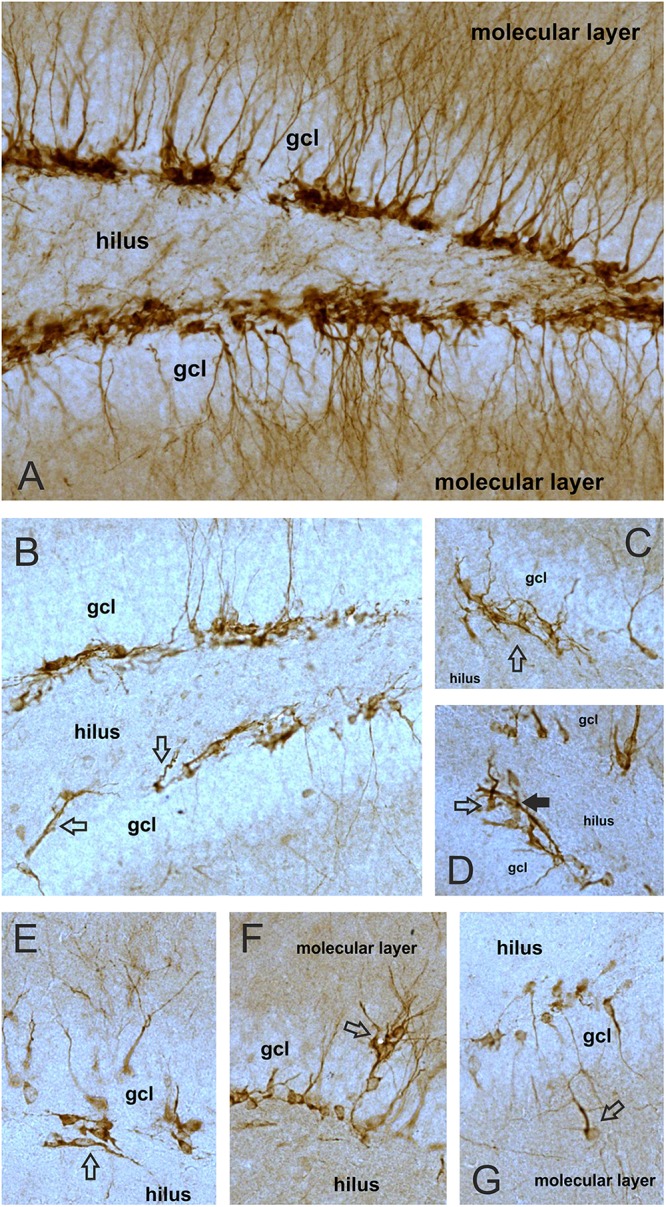
Long-term cannabis exposure alters the morphology of DCX-positive neurons. Representative images demonstrating DCX+ immature neurons with normal appearance in a control animal (A) and cells with abnormal morphology in cannabis treated mice (B–G). (A) In control mice almost all the DCX+ neurons were located in the subgranular zone, i.e., in a cell layer between the hilus and granule cell layer (gcl). Normal DCX+ cells had DCX-expressing dendrites projecting through the gcl and arborized in the molecular layer. The principal dendrites were typically running parallel to each other in the gcl giving an orderly, well-aligned appearance to the neurons. (B) DCX+ neurons in the cannabis treated animals often lost their dendritic DCX-expression. Arrows point to neurons with abnormal dendritic projections into the hilus. (C) DCX+ neurons with dendrites projecting into all directions, giving a disorganized, chaotic appearance to the neurons. (D) Open arrow points to a neuron with basal dendrites, i.e., with dendritic projections into the hilus. Black arrow points to a cell with bipolar appearance. (E) A bipolar DCX+ neuron in the hilus with dendritic projections running parallel to the gcl. (F) Neurons migrating out of the gcl into the molecular layer. (G) An ectopic DCX+ neuron with basal dendrite that migrated completely out of the gcl into the molecular layer. All images were taken with the same magnification (20× objective).